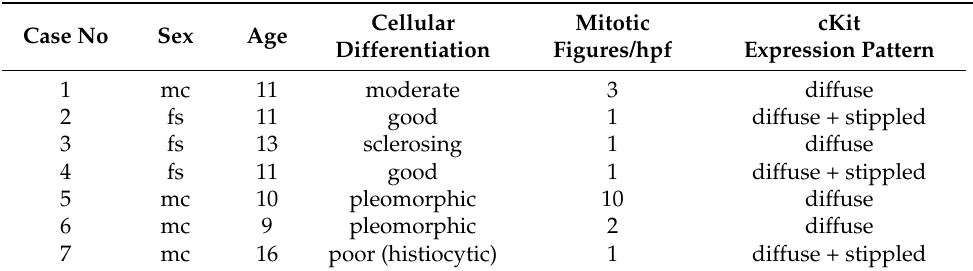
Table 7. Feline intestinal mast cell tumours included in the present study ( n = 7, all DSH). Case